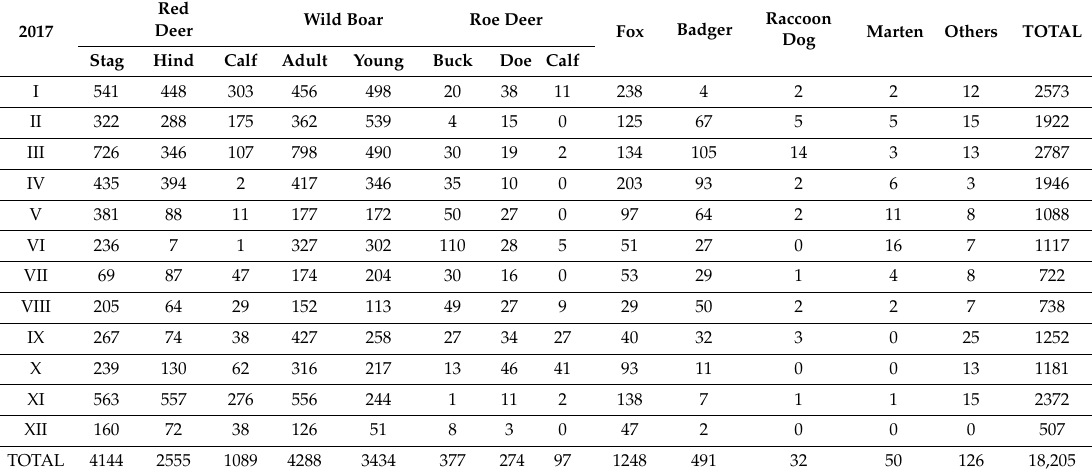
Table 1. Results of studies on wildlife migrations recorded using a monitoring set in